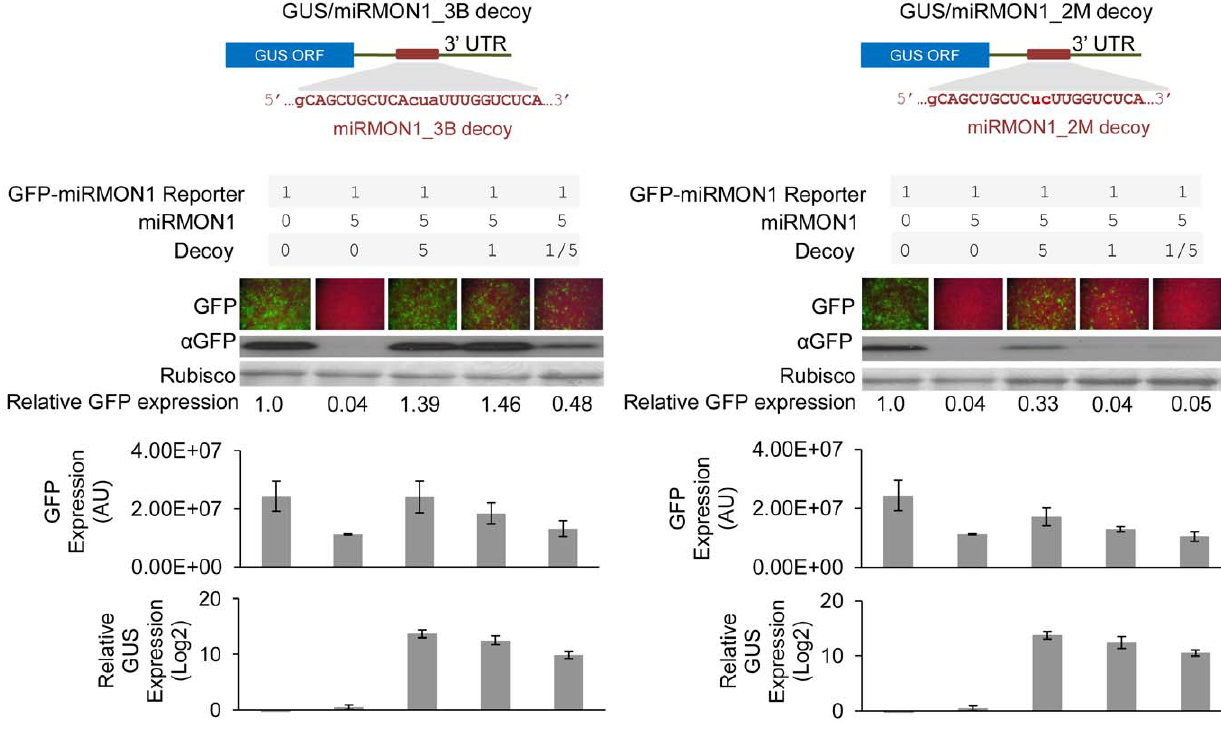
Figure 3. Effect of stoichiometry on activity of two miRMON1 decoys (bulged, miRMON1_3 B decoy, and mismatched, miRMON1_2 M decoy). Diagram of miRMON1_3B and 2M decoys embedded in the 3 9 UTR of a GUS coding transcript and expression of miRMON1-targeted GFP reporter co-expressed with various concentrations of miRNA decoys in N. benthamiana leaves. Leaves were co-transformed with one part GFP reporter, 5 parts miRMON1, and variable parts miRNA decoy. Agrobacterium transformed with an empty vector was added to achieve a total OD 600 =1 of Agrobacterium for each transformation. GFP expression was measured by fluorescence microscopy and protein blot. The Rubisco band visualized by Ponceau staining shows the loading control. Relative GFP expression normalized to Rubisco and relative GUS expression as measured by qRT-PCR are indicated.